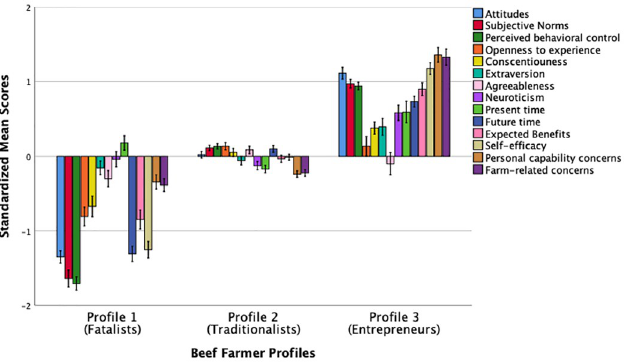
Fig 1. Standardized mean scores ( M = 0, SD = 1) of different psychological characteristics across three beef farmer profiles. Error bars represent standard errors (SE) ±